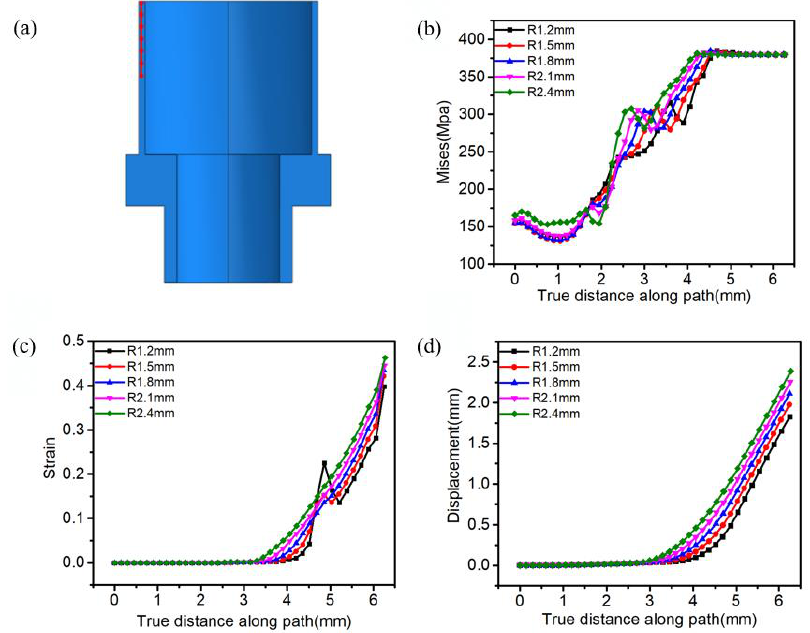
Figure 5. Effect of nosing die’s fillet radius (R) on the equivalent stress ( b ), equivalent plastic strain ( c ), and radial displacement ( d ) of different points on the path ( a ).